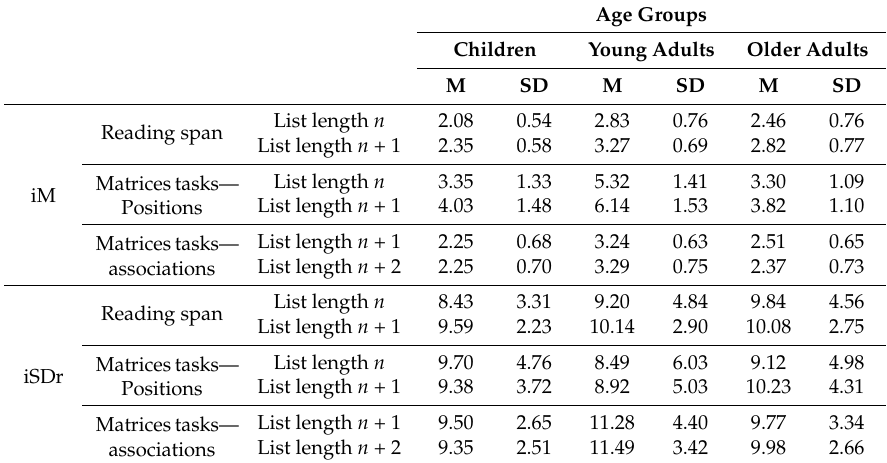
Table 4. Accuracy tasks: Means (iM) and intra-individual standard deviation of residual scores (iSDr) by Age